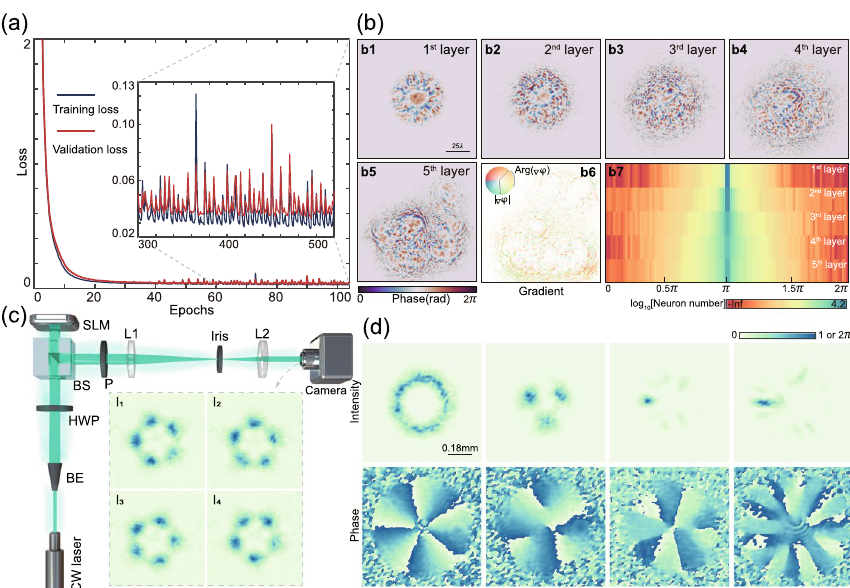
Fig. 2 Training results and experimental data collection. a The loss curves of training set and validation set versus updating epochs. The learning rate is tuned dynamically every 15 epochs. The POAM converges after dozens of epochs and the inset indicates that the neural network is not overfitting. The loss value is the sum of 300 (one batch) samples. b Final designs of the optical diffractive network. (b1 - b5) Five cascaded diffractive layers with a fixed distance of 40 (cid:31) between two successive layers. (b6) The gradient distributions of the 5th layer. PS: Color-encoded gradient map. (b7) Phase value distributions of 5 diffractive layers. c The optical setup for generating experimental structured light. CW laser, continuous-wave laser; BE, beam expander; HWP, half-wave plate; BS, beam splitter; SLM, spatial light modulator; P, polarizer; L1, L2, lens. For each data sample, we reconstruct the complex optical fields using 4-step phase shift method as depicted in the inset (I 1 , I 2 , I 3 , I 4 ). See details in Supplementary Note 1. d Four selective reconstruction results based on c , − 4, − 1, equal weights), mul. mode (TC − 4, which are single mode (TC 5), multiplexed (mul.) mode (TC = = = − 3, 2, 5, equal weights), mul. mode (TC − 10 ~ 10, random weights), from left to =